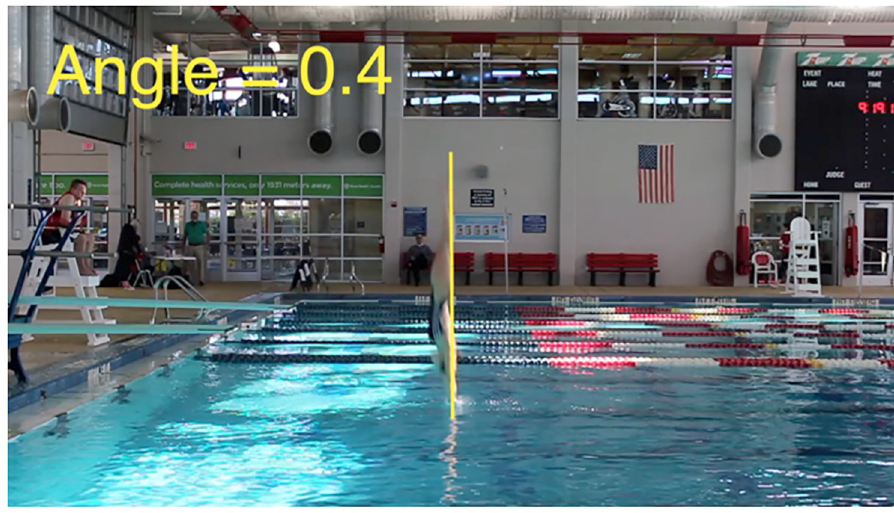
Fig 3. Measuring angle of dive entry. Still photo illustrating how angle of diver entry to the water was measured from the recorded footage.